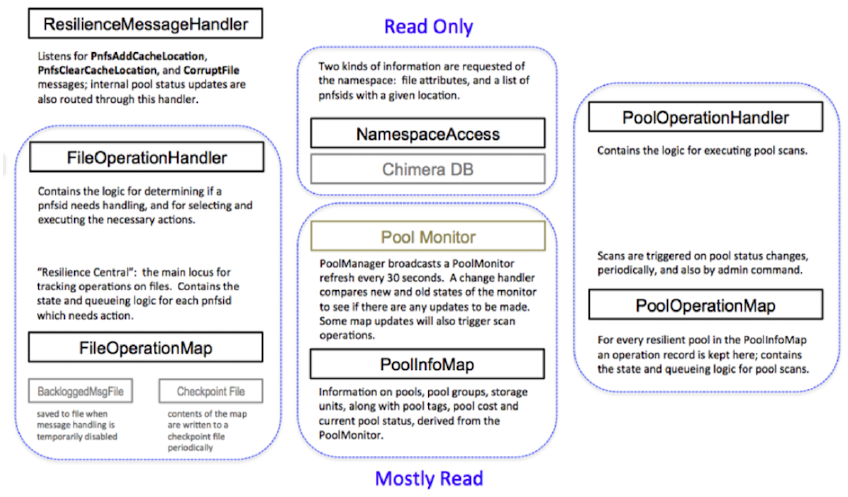
Figure 2. Resilience service